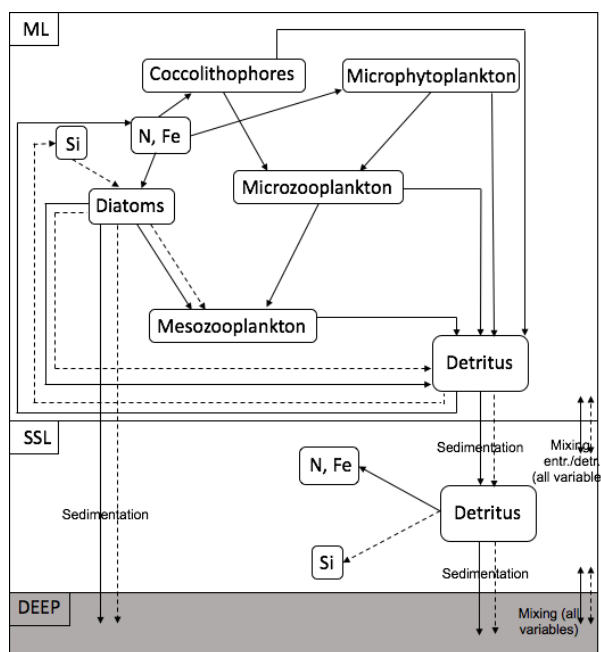
Figure 4. Structure of the ecosystem within one box model. The full arrows represent the flow of nitrogen and iron; the dashed arrows represent the flow of